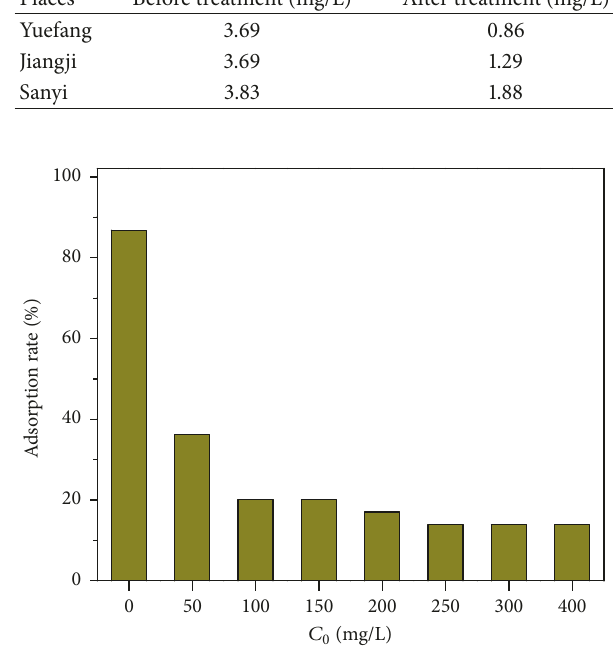
Figure 8: Effect of HCO 3− on the adsorption efficiency (conditions: adsorption time, 24 h; initial concentration of F − , 3 mg/L; amount of adsorbent, 1.0g/L; pH =